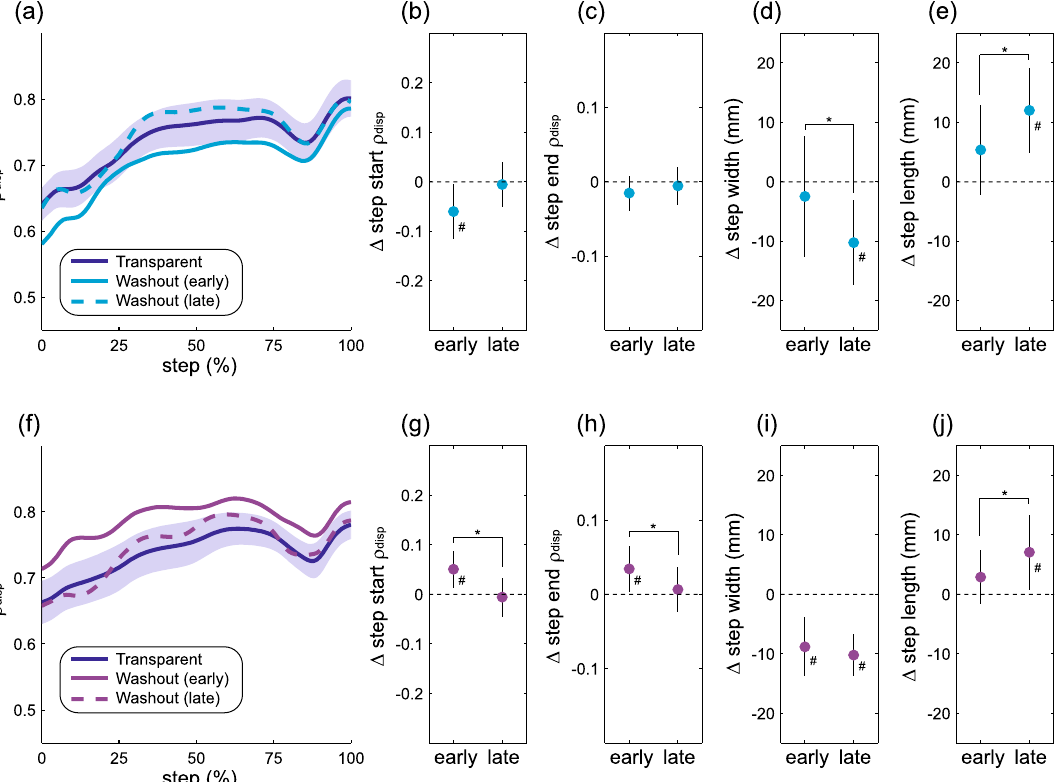
Figure 5. Gait behavior over the course of the first washout period. The top row ( a – e ) illustrates potential after-effects of force field assistance, while the bottom row ( f – j ) illustrates potential after-effects of force-field perturbations. For all comparisons, “early” refers to the first 45 steps, while “late” refers to steps 181–225. The structure of the figure is the same as that described for Fig. 3, with ρ disp representing the partial correlation between pelvis displacement and step